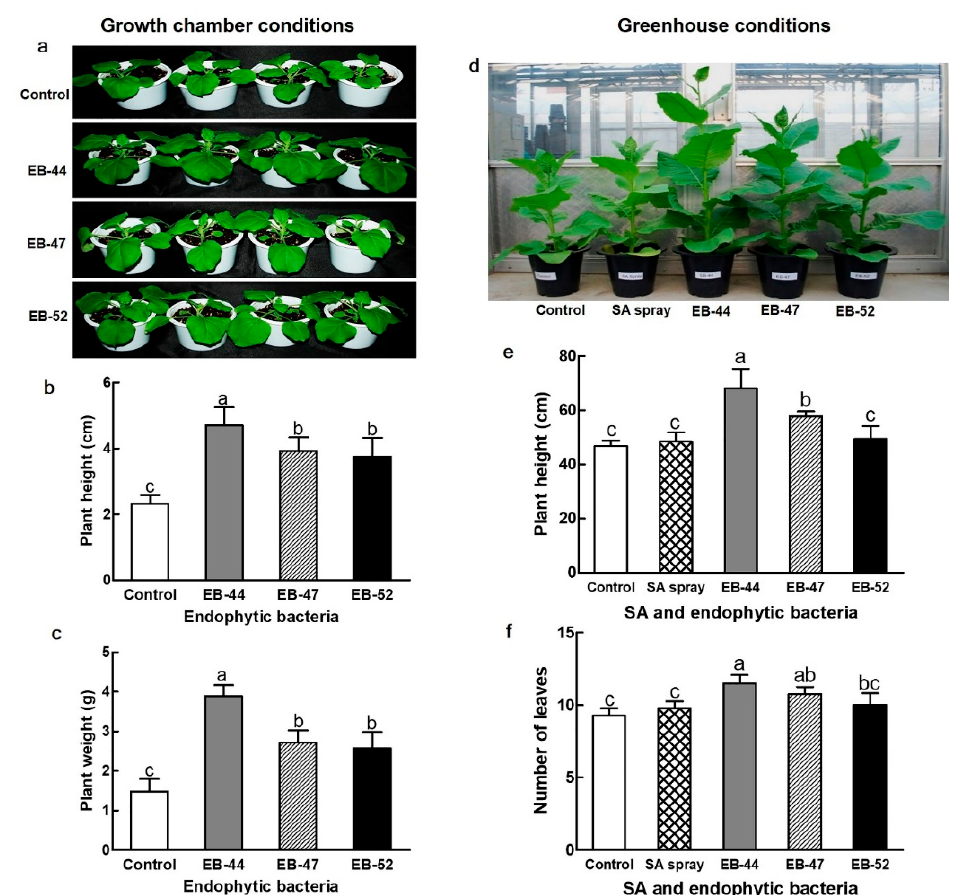
Figure 4. Growth-promoting effect of salicylic acid (SA)-producing endophytic bacteria (EB) in Nicotiana. ( a – c ) Growth comparison of 3-week-old Nicotiana benthamiana plants in response to seed treatment with SA-producing EB or distilled water (Control). ( d – f ) Growth comparison of 8-week-old N. tabacum plants in response to seed treatment with SA-producing EB or water (Control). Data represent means ± standard deviations of four independent replications for each treatment. Means with different letters are significantly different at p < 0.05 by Duncan’s multiple range test.